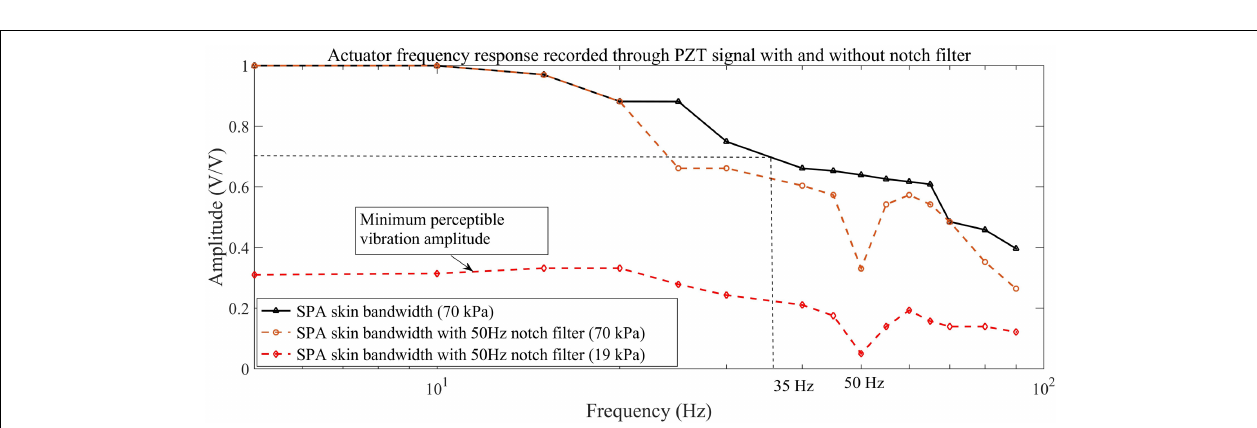
FIGURE 6 | Filtering effect of second-order notch filter on PZT signal quality . The raw sensor data are acquired for vibrotactile actuation of 20Hz (A) and 70Hz (B) . The raw sensor data contain large component of line noise, which is suppressed using the second digital notch filter.